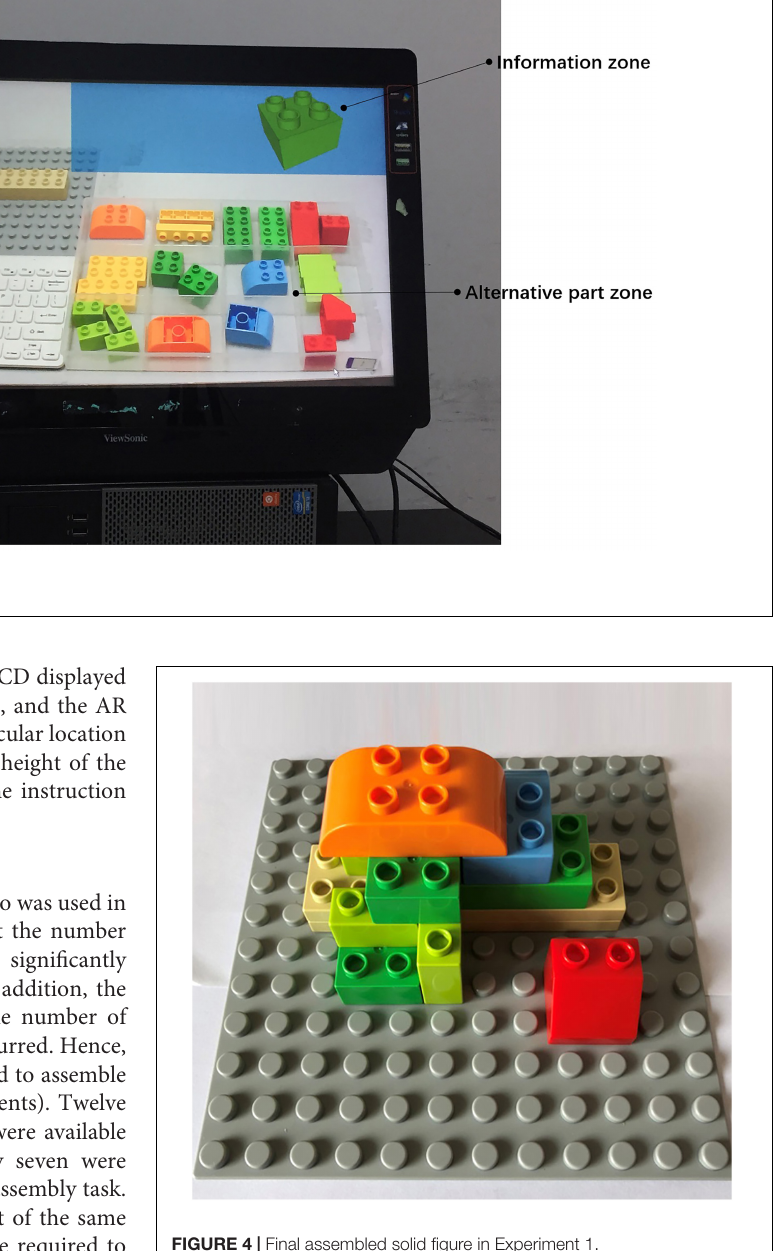
FIGURE 4 | Final assembled solid figure in Experiment